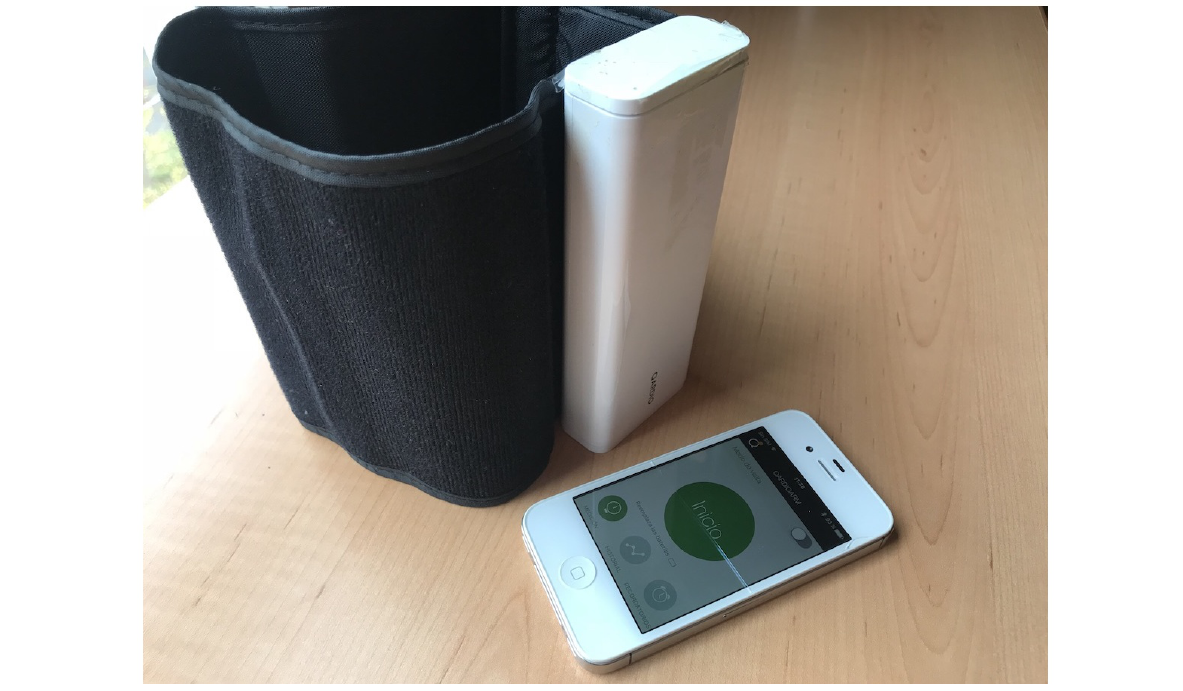
Figure 1. QardioArm is a device with a cuff used with an app for visualization of blood pressure known as